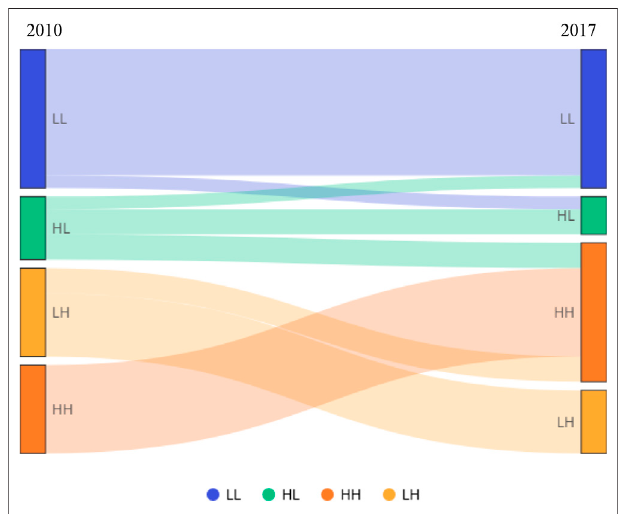
FIGURE 9 | The transformation of spatial aggregation patterns of the coupling coordination